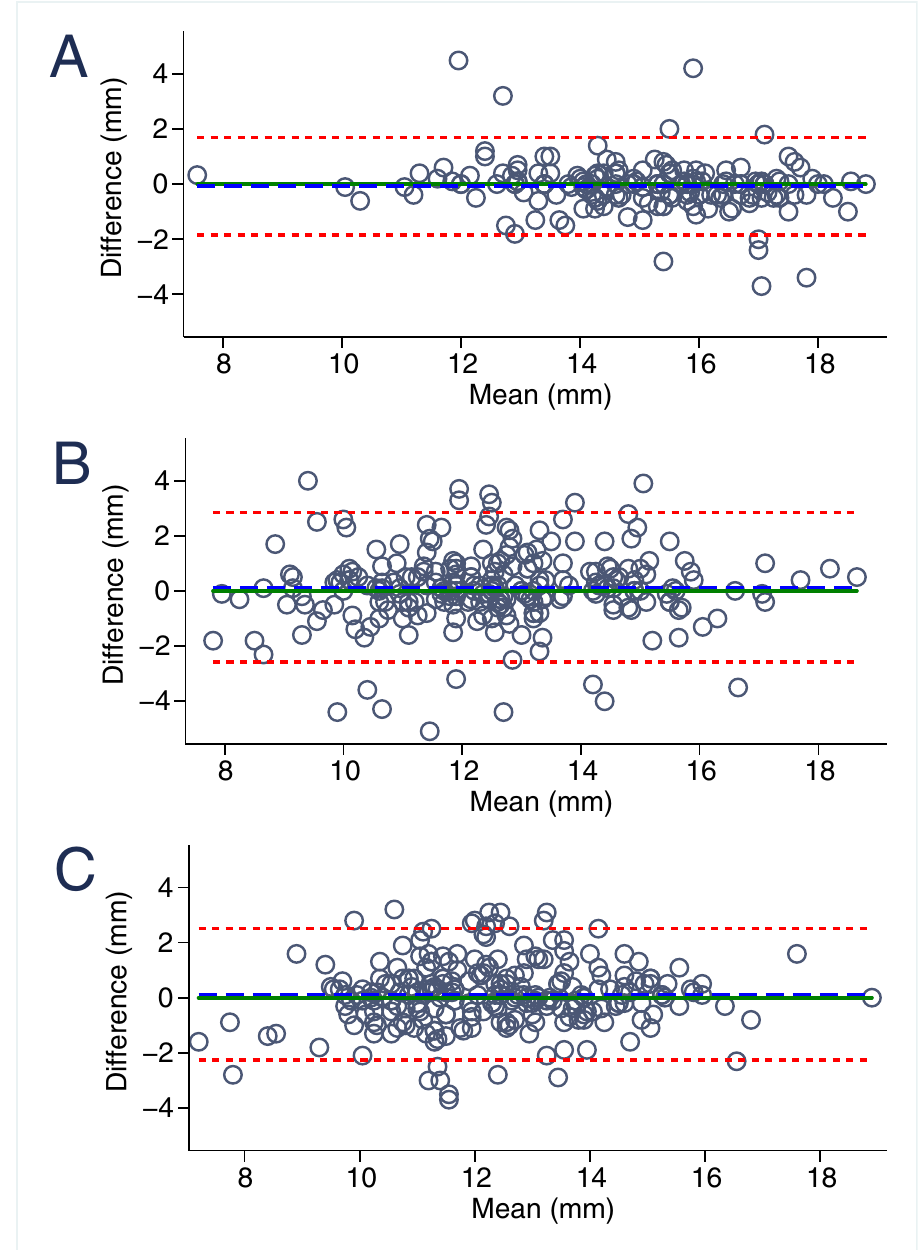
Fig 2. Bland-Altmann graphic: Reproducibility of MAPSE imaging. A. Interobserver variability for m-mode derived MAPSE, B. Interobserver variability for B-Mode lateral derived MAPSE, C. Interobserver variability for B-Mode septal derived